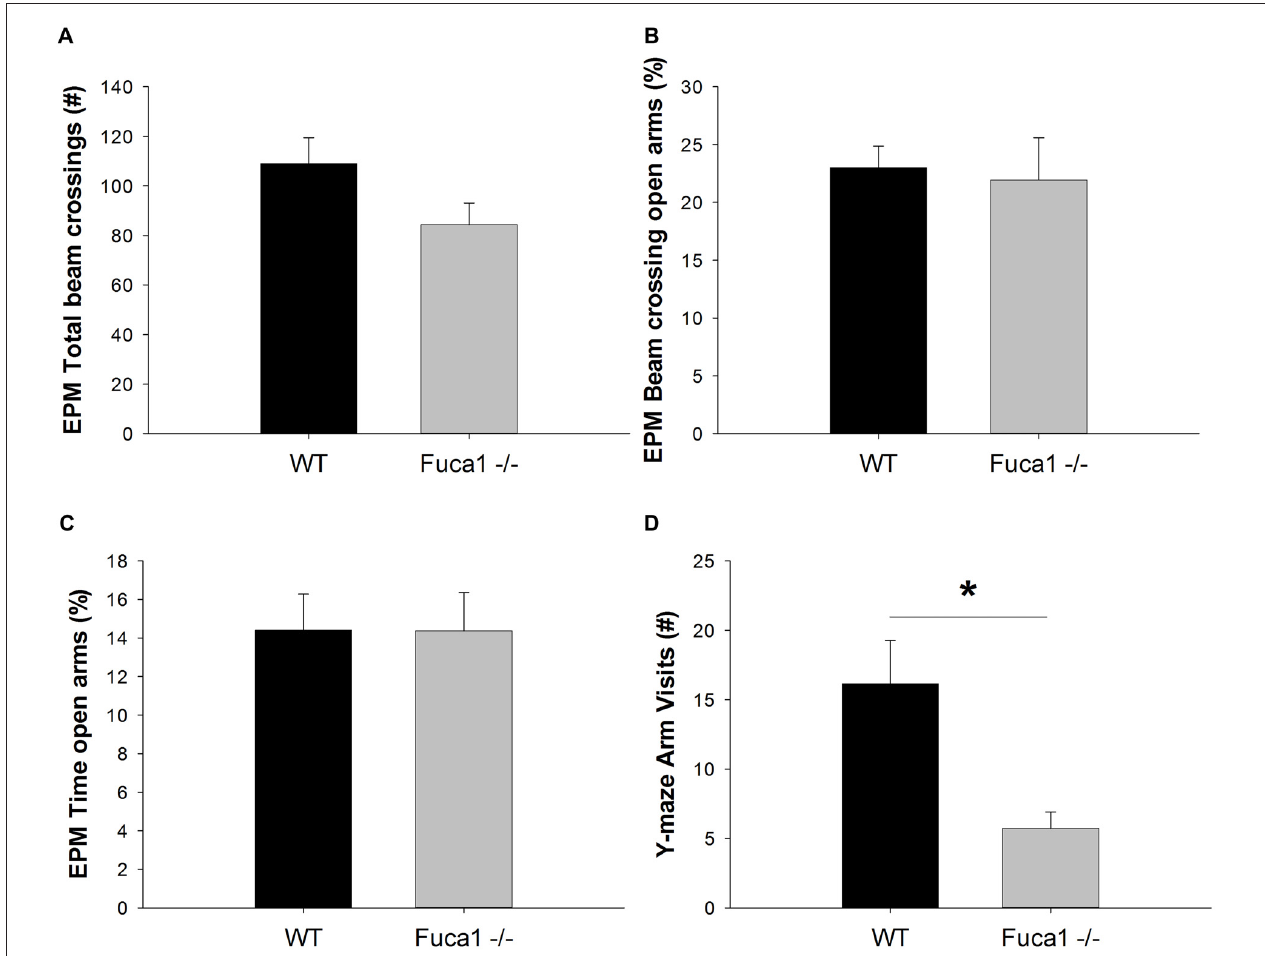
FIGURE 7 | Fuca1-deficient mice show reduced exploratory activity but no changes in anxiety levels. (A–C) Elevated plus maze exploration in 3-month-old Fuca1-deficient mice (Fuca1 -/-, gray bars) and age-matched WT littermates (black bars). Total beam crossings tended to be decreased in Fuca1-deficient mice (A) , but relative exploratory activity (B) and time (C) in open vs. closed arms was similar to WT littermates. (D) Y-maze exploration in 3-month-old Fuca1-deficient mice (Fuca1 -/-, gray bar) and age-matched WT littermates (WT, black bar). Fuca1-deficient mice were significantly less active in the Y-maze. The low amount of arm visits precluded assessment of spontaneous alternations for evaluation of working memory. All data are presented as mean ± SEM (both genotypes n = 15). Abbreviations: EPM, elevated plus maze. Asterisk indicates significance of